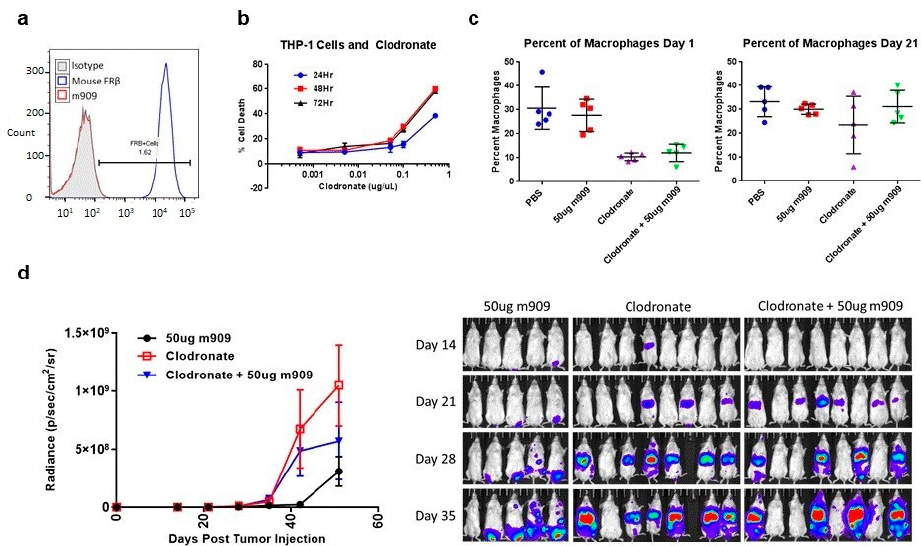
Figure 5. m909 activity in vivo after macrophage depletion. ( a ) m909 does not cross react with mouse FR β . ( b ) In vitro co-culture of THP-1 cells in the presence of liposomal clodronate at different concentrations for 24, 48, and 72 h shows increasing toxicity at higher concentrations. Error bars represent standard deviation. ( c ) Blood draws from five mice in each treatment group demonstrate the percentage of macrophages on day 1 and day 21. 300 μ L of liposomal clodronate was given on day − 1 and repeated small dose of 25 μ L every 5 days until the end of antibody dosing. Error bars represent standard deviation. ( d ) Mice injected with 2 × 10 6 THP-1 cells on day 0 and then treated with m909 for 10 doses starting day 2 as in previous experiments as well as liposomal clodronate. m909 still has an impact on tumor growth even in the presence of liposomal clodronate. Error bars represent standard error.